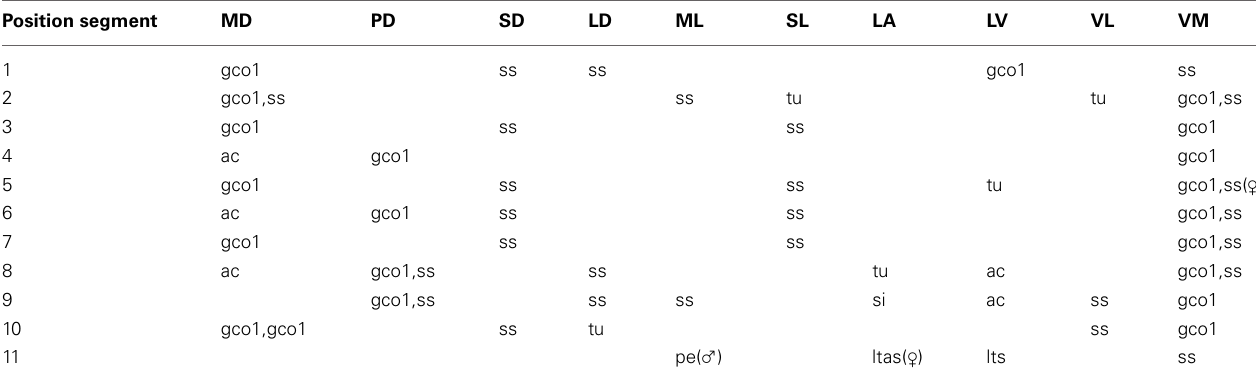
Table 5 | Summary of nature and location of sensory spots, glandular cell outlets, tubes, and spines arranged by series in Echinoderes skipperae sp.